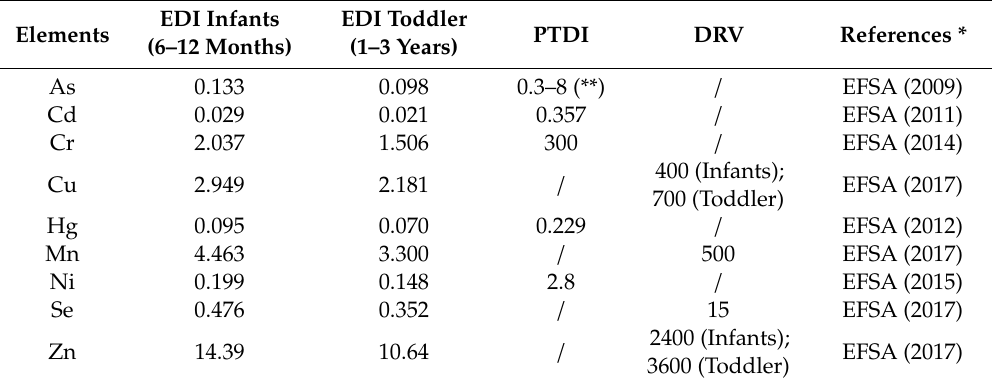
Table 3. Estimated Daily Intake (EDI) ( µ g / Kg bw day) calculated for Infants (6–12 months) and Toddlers (1–3 years) compared with the Provisional Tolerable Daily Intake (PTDI) for toxic metals and with the Dietary Reference Value (DRV) for essential micro / macronutrients.